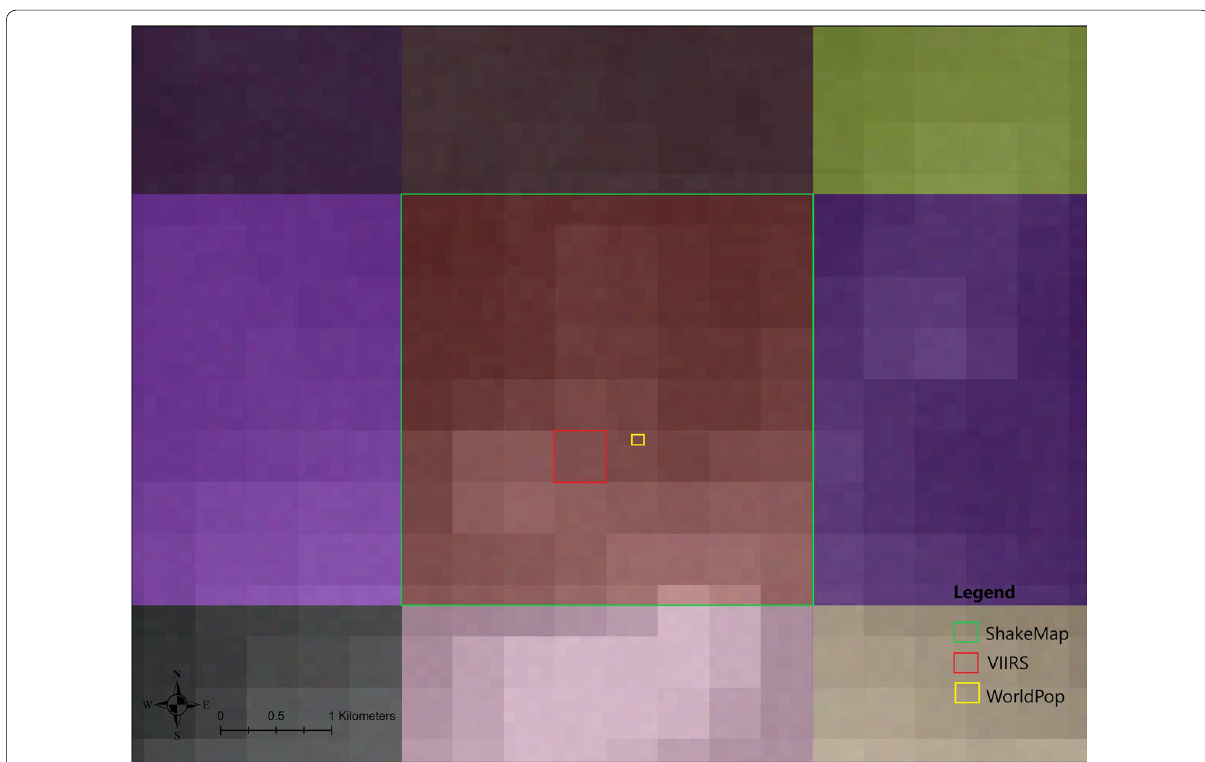
Fig. 5 Comparison of the spatial resolution of the ShakeMap, the VIIRS nightlight data and the WorldPop